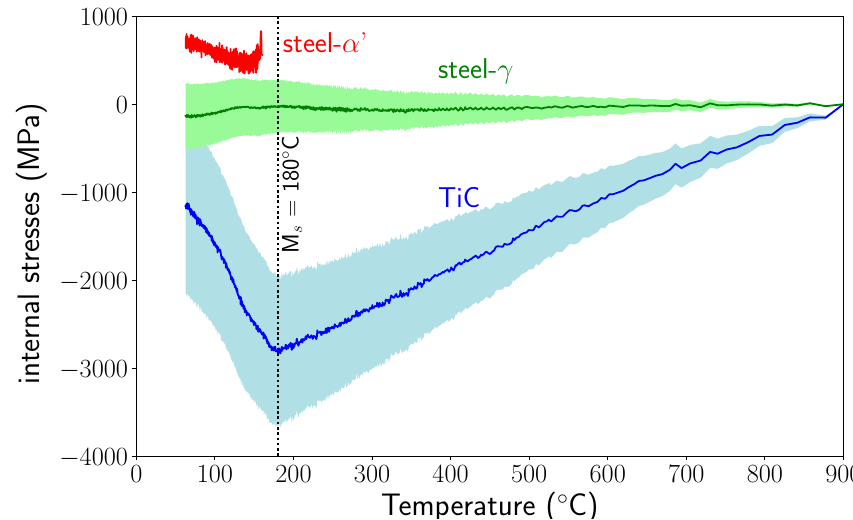
Figure 13. Internal stress evolutions during cooling (because the stress states are hydrostatic, only one component of the stress tensor is presented). Envelopes show the stress variations introduced by uncertainties in thermal expansion coefficients (see Section